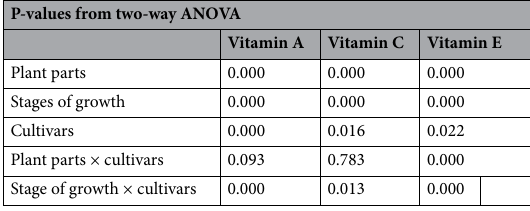
Table 6. ANOVA analysis of Vitamins in roselle.